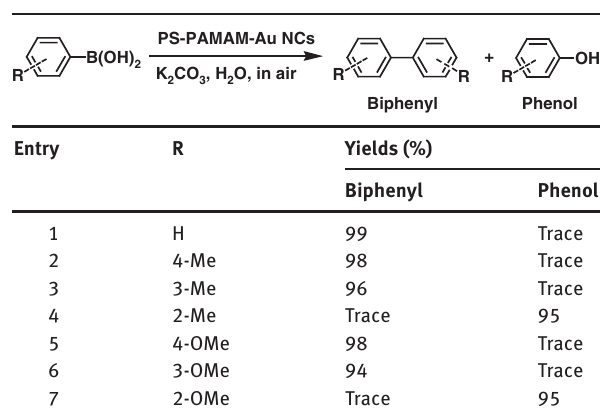
Table 2 Homocoupling of various arylboronic acids catalyzed by PS-PAMAM-Au NCs (data from